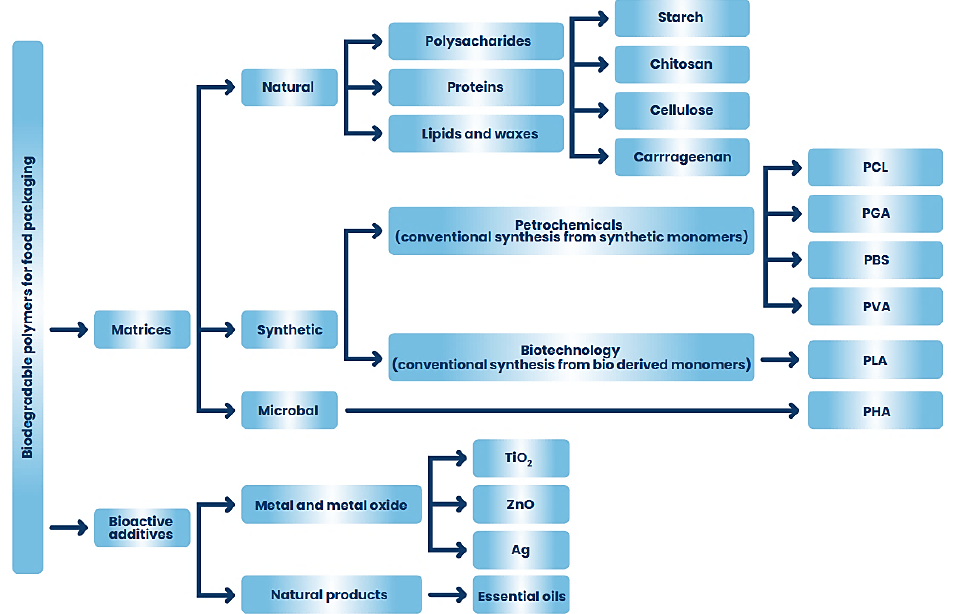
Figure 24. Classification and application of antibacterial polymers in the production of food pack- aging.